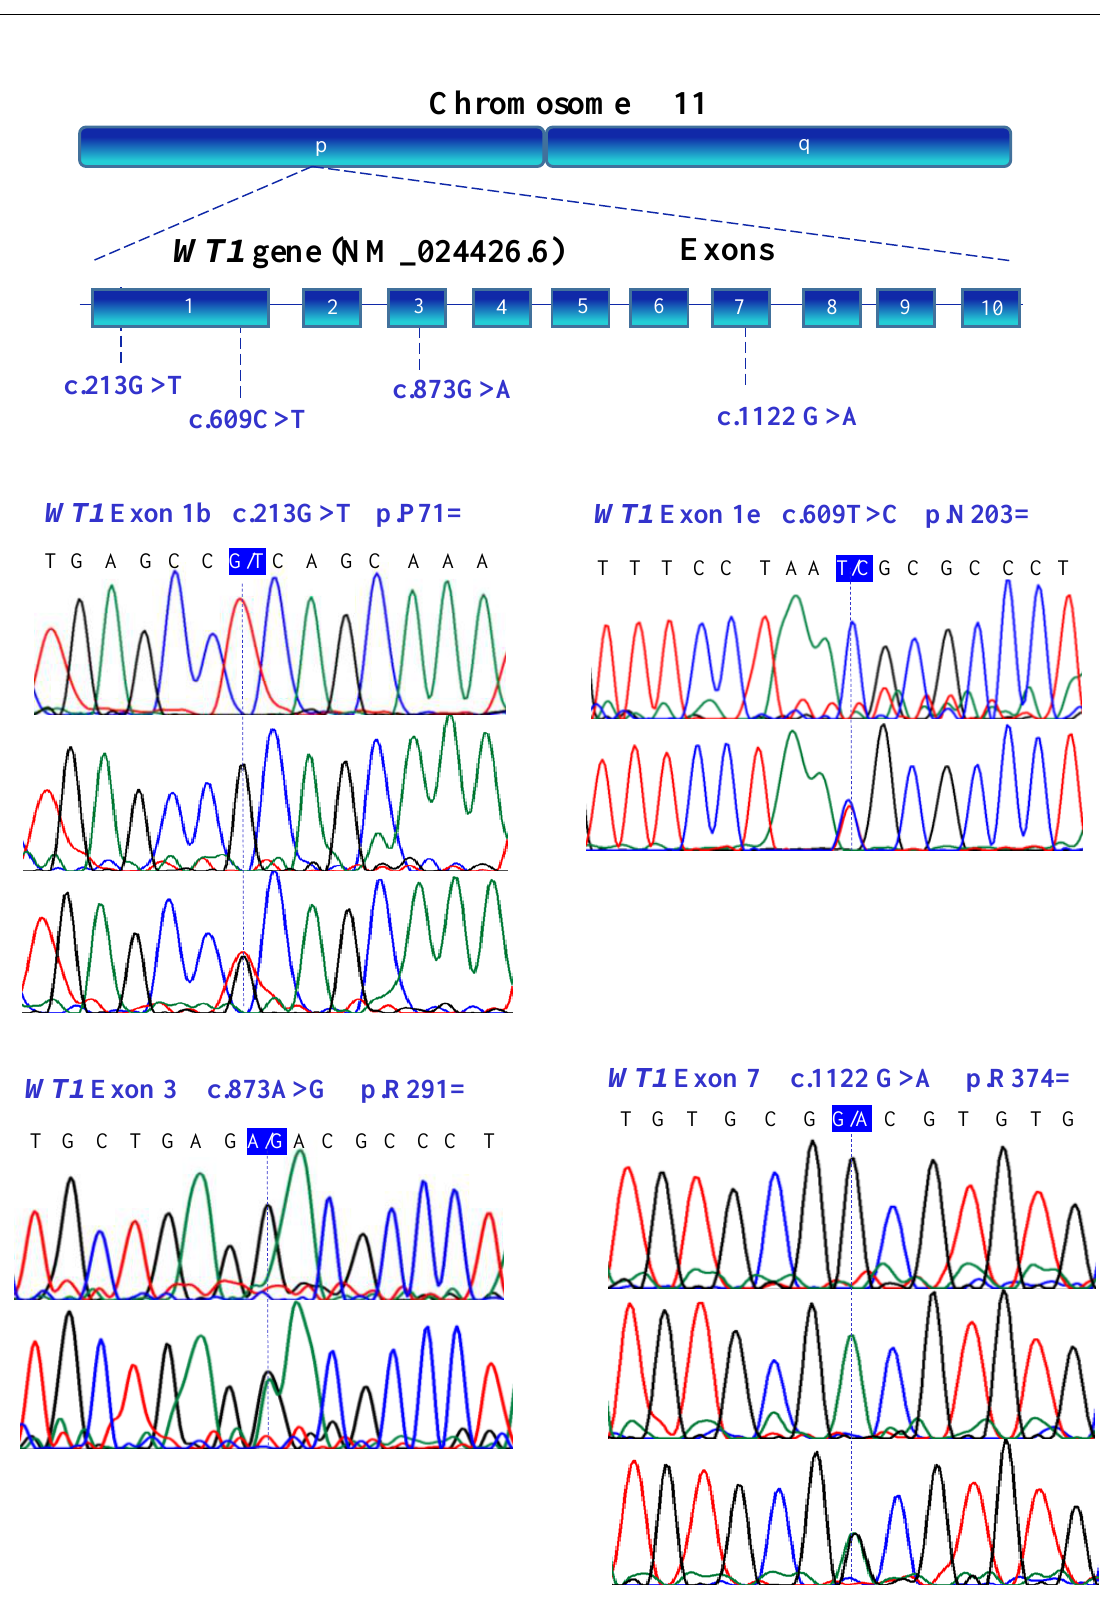
Figure 3. Schematic illustration of amplified exons from the human WT1 (NM_024426.6) gene located on chromosome 11. Exons (1–10) are represented by blue boxes. Partial nucleotide sequences of the human WT1 gene were obtained by bidirectional Sanger sequencing from patients with POI. The human genome sequence revealed that the WT1 gene contains four synonymous